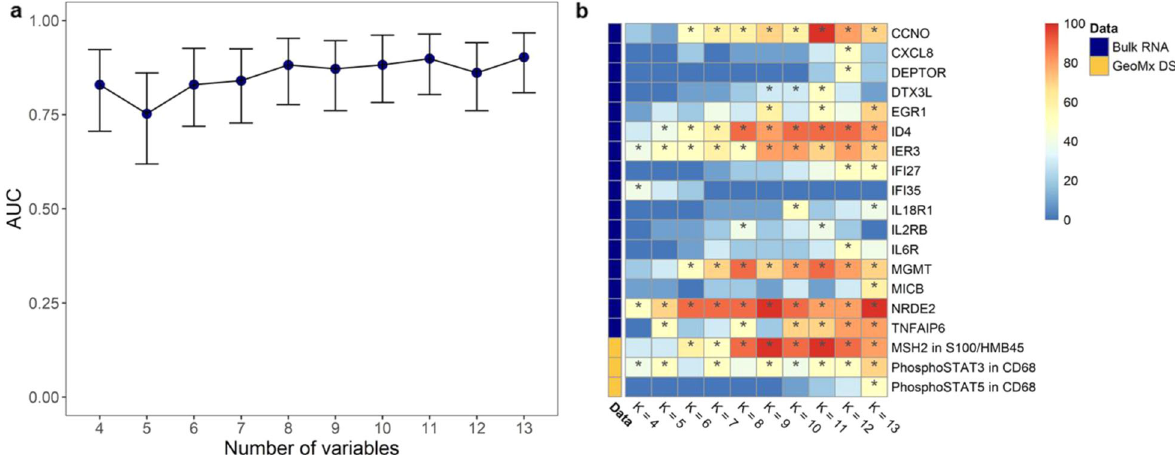
Fig. 3 Generation of Yale Mixed Modality Model (YMMM) for the prediction of best overall response to immunotherapy in patients with advanced melanoma. a Identi fi cation of the optimal number of predictors for fi nal model inclusion. Area under the curve (AUC) and 95% con fi dence intervals based on the number of predictors included in the model; AUC curve peaks when 8 predictors are included in the model. b Heatmap showing the most frequently appearing predictors for any given number of variables included in the model (K); calculations are based on the top ten highest AUC models for different K values. For K = 8, selected predictors are CCNO , ID4 , IER3 , IL2RB , MGMT , NRDE2 , TNFAIP6, and MSH2 in